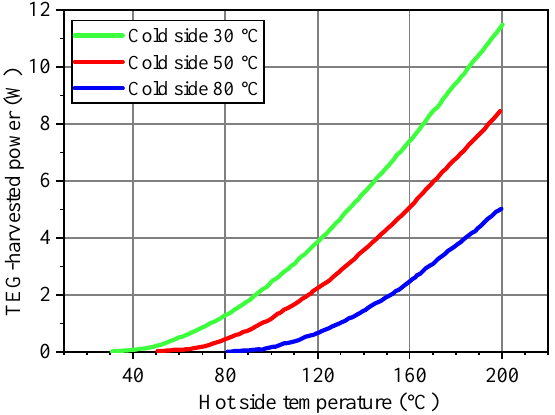
Figure 5. TEG-harvested power according to the hot side and cold side temperature [38].